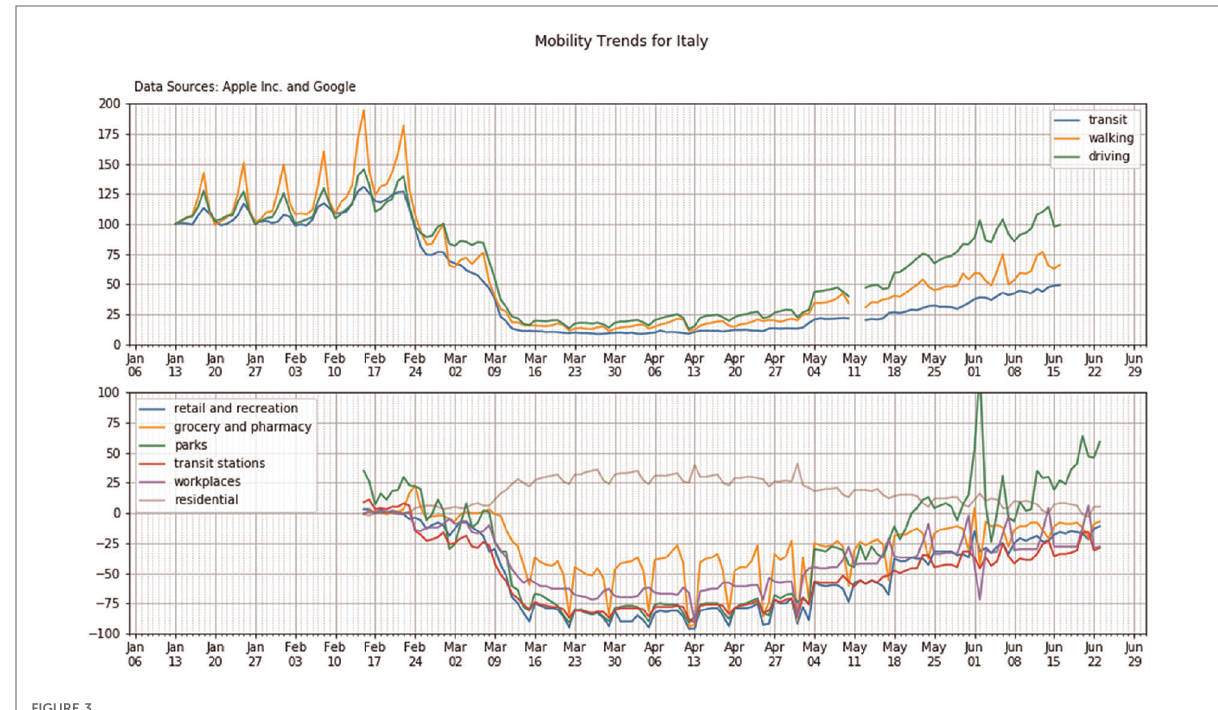
FIGURE 3 Time alignment of the Apple and Google data on the top and bottom panels, respectively (country: